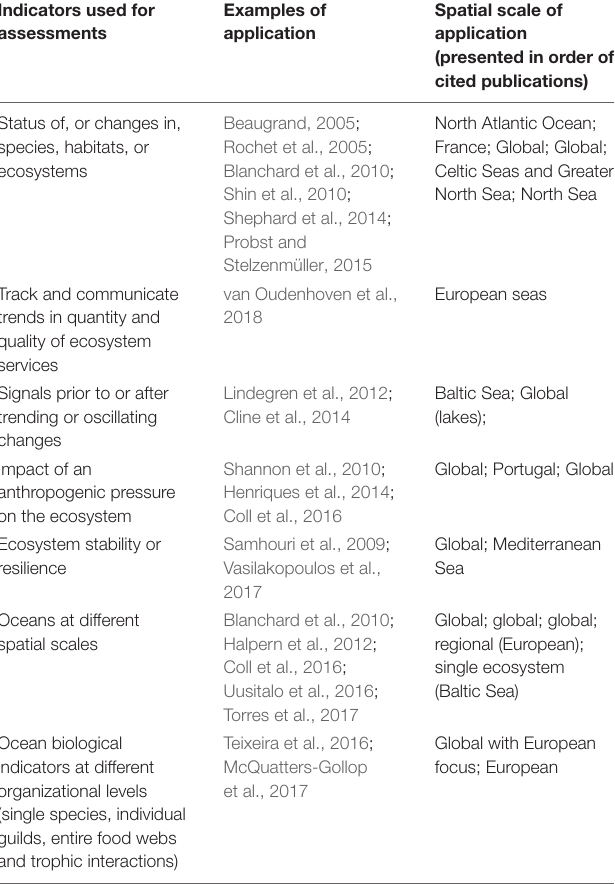
TABLE 1 | Applications of biodiversity indicators relevant to marine environments and global marine conservation policy and management. Indicators used for Examples of assessments